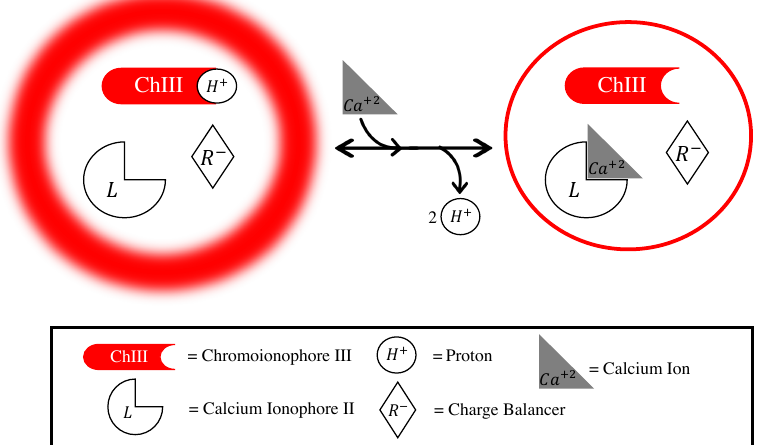
Figure 1. The LipiSensor ion exchange mechanism in response to increasing concentrations of Ca + 2 . The particles have a higher fluorescence at low [Ca + 2 ] as the reporter dye (chromoionophore III) is protonated. As [Ca + 2 ] increases, it is extracted into the core of the sensor and protons are excluded through ion exchange. This deprotonation is reflected as a decrease in nanosensor fluorescence. This equilibrium-driven process is fully reversible upon decreasing calcium concentration.